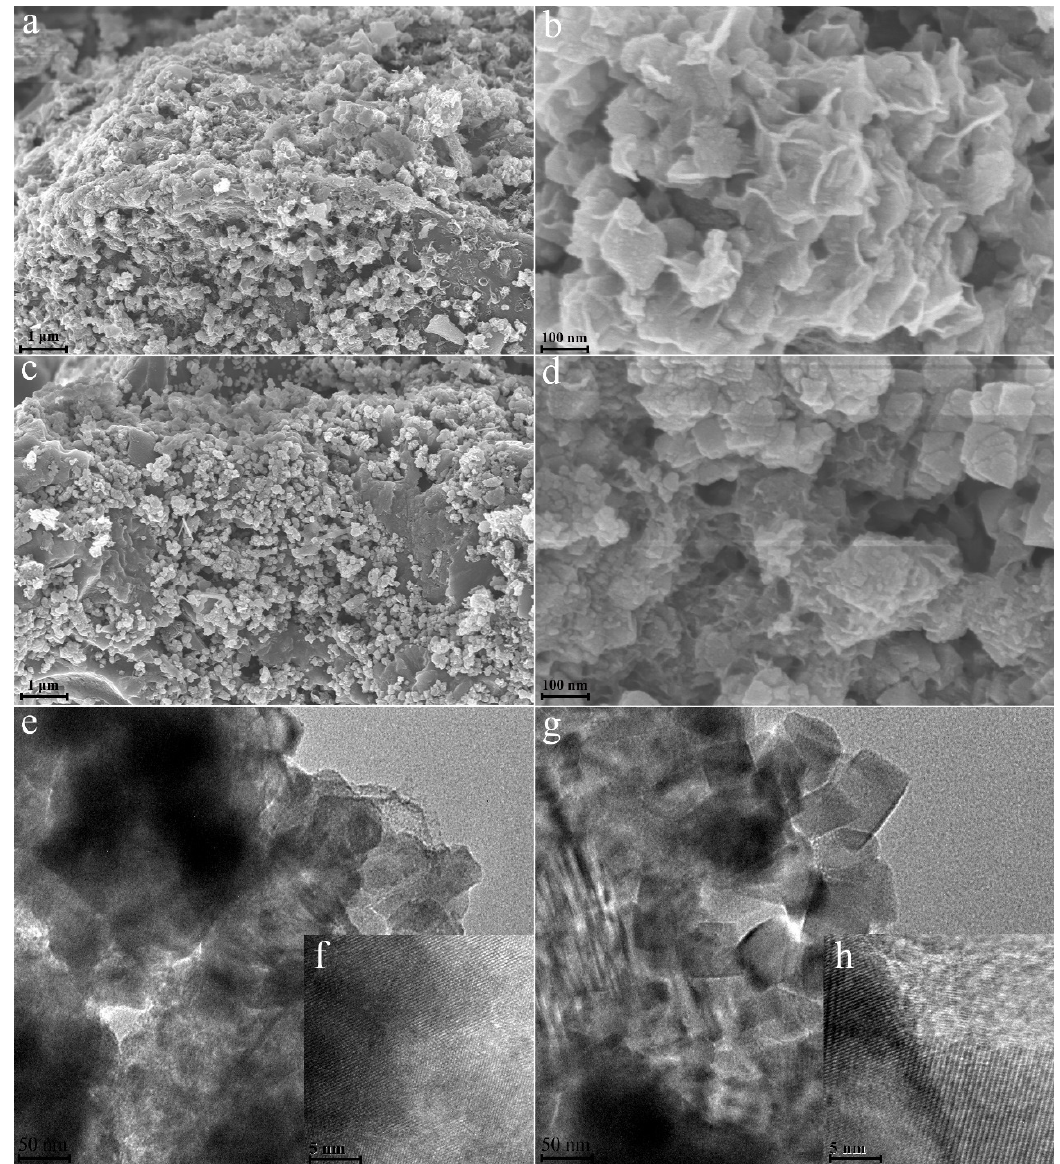
Figure 1. Morphology characteristics of porous carbon&Ti 3 C 2 Tx Composites. A, b, e, and f represent the deionized water as the medium (( a , b ) refer to SEM images, ( e , f ) refer to TEM images.). ( c , d , g , h ) represent the acetone as the medium ( c , d ) refer to SEM images, ( g , h ) refers to TEM images).